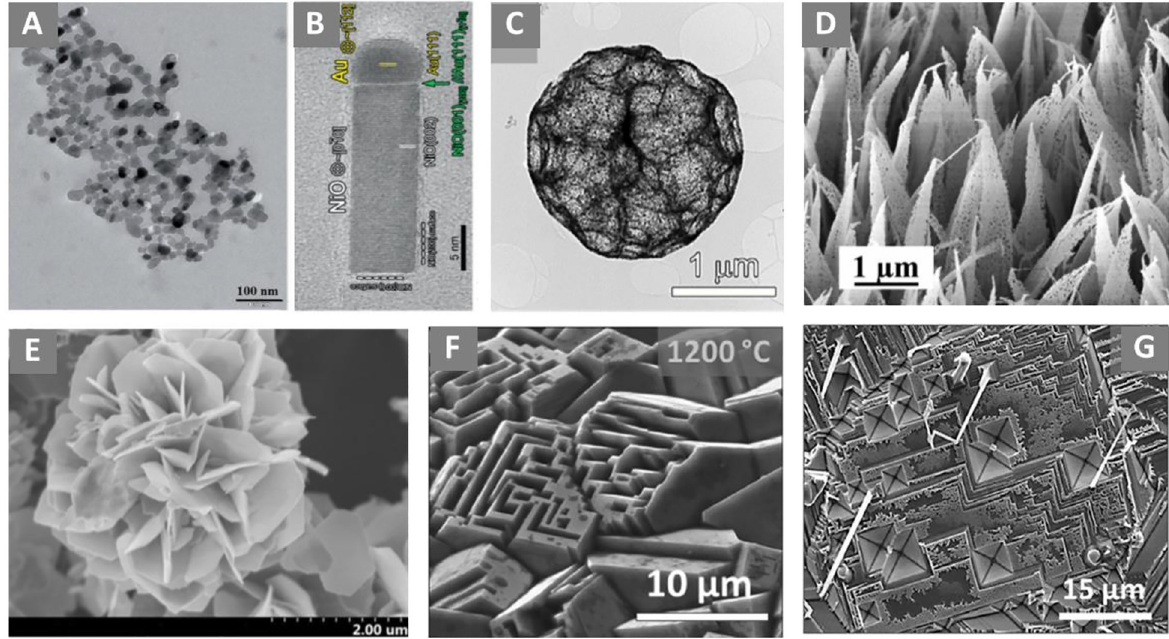
Figure 1: (A) NiO nanoparticles synthesizedby sol – gel reproduced from Ref. [41]with permissionfrom the Royal Society of Chemistry. (B)